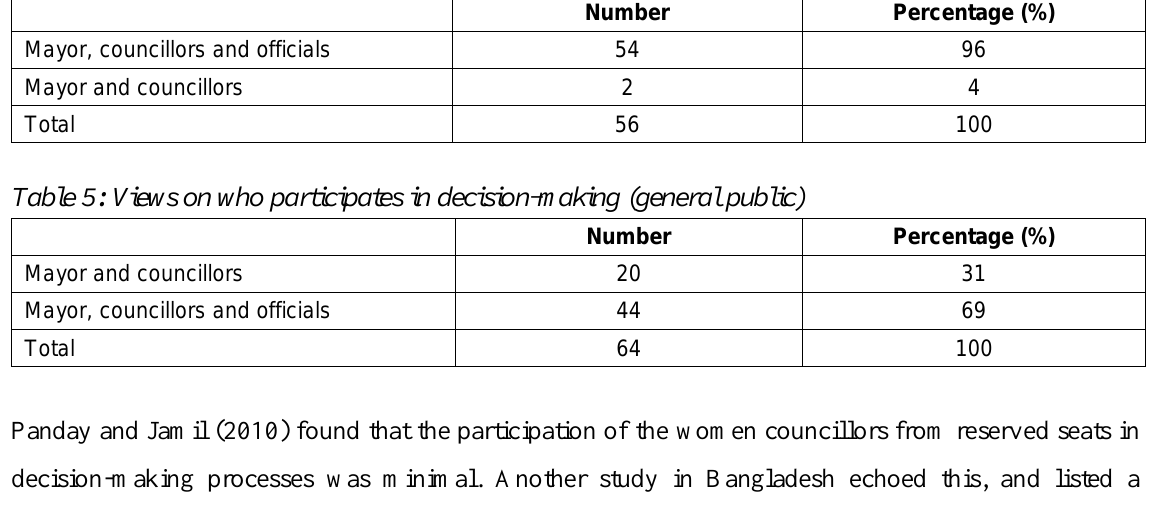
Table 4: Views on who participates in decision-making (representatives and officials) Number Percentage (%)